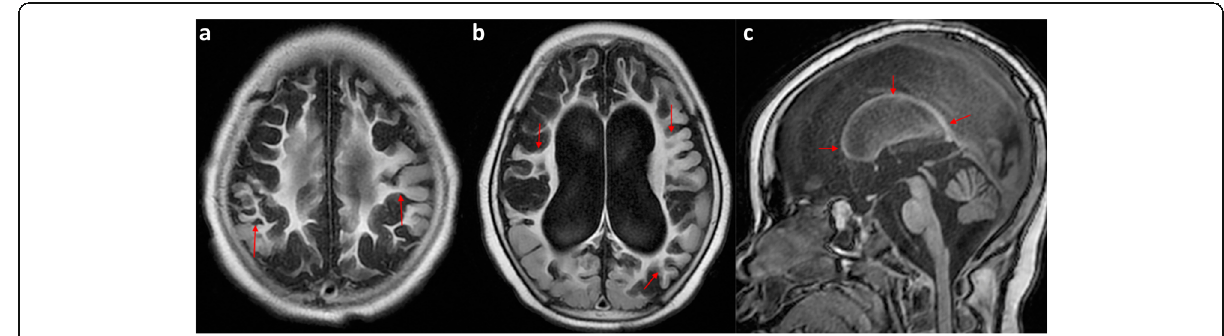
Fig. 15 a – c MRI imaging in a 5-year-old girl who sustained a severe partial-prolonged hypoxic-ischaemic injury at term gestation. The sequential FLAIR images from the vertex ( a ) to the level of the lateral ventricle bodies ( b ) demonstrates severe volume loss of both cortex and subcortical white matter extending to involve the deep white matter of the entire cerebral hemisphere bilaterally, with only a strip of periventricular white matter remaining and showing abnormal high signal throughout. There is also prominent ulegyria (arrows) of the watershed continuum from anterior, over the vertex, through the peri-Sylvian region, and into the posterior watershed. The sagittal midline T1-weighted image ( c ) demonstrates corresponding corpus callosum thinning throughout its length